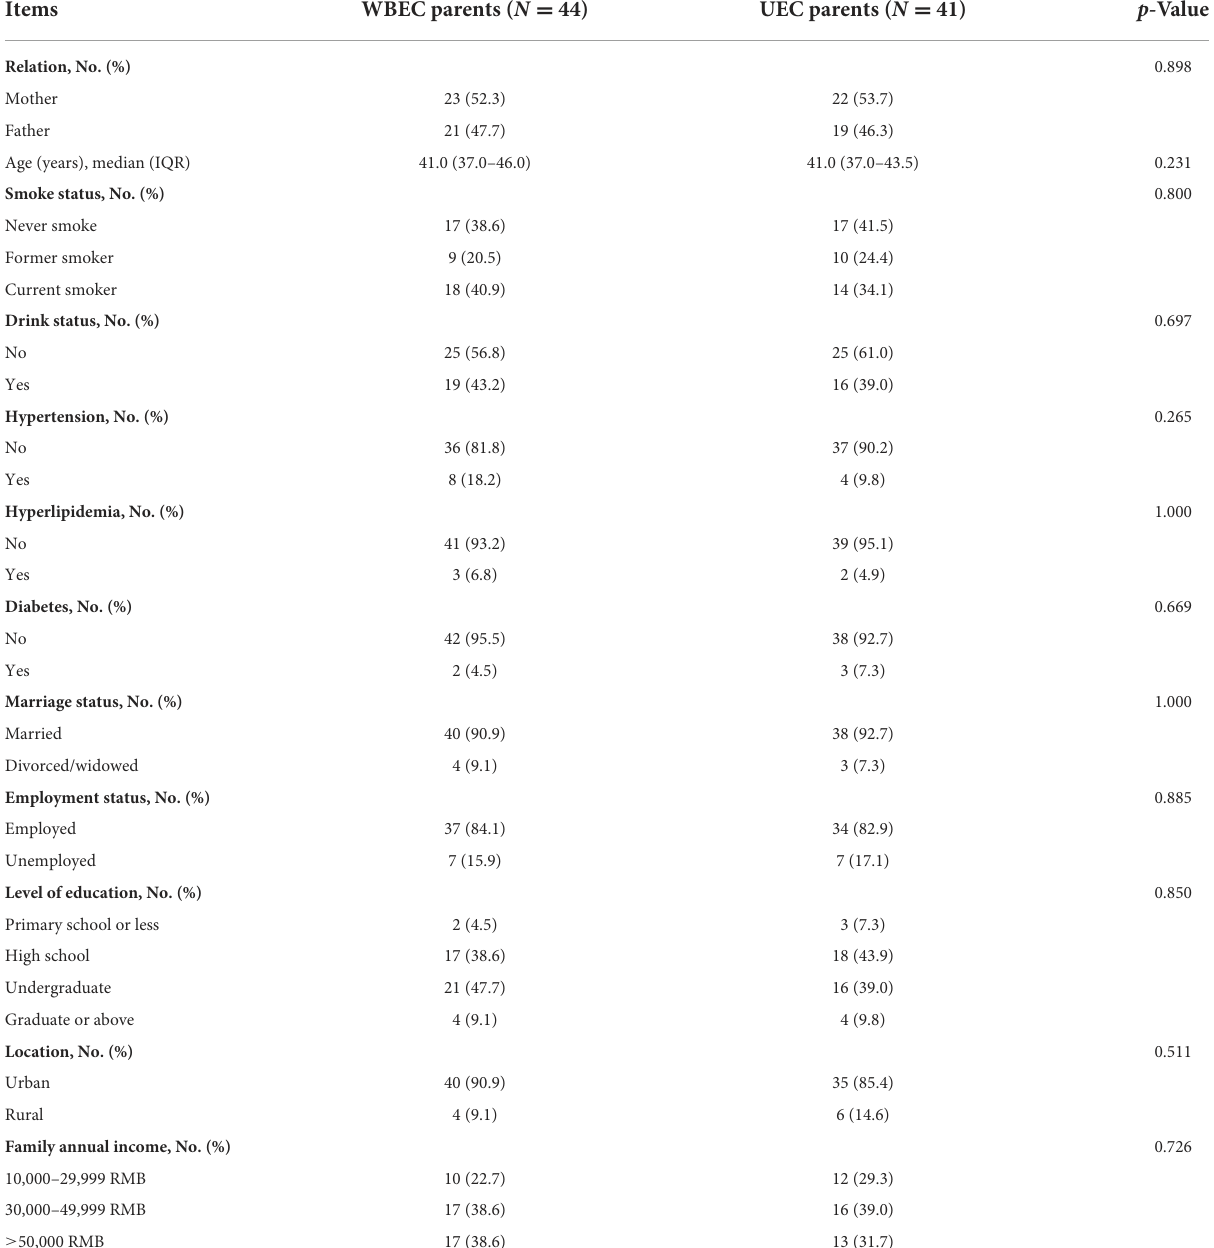
TABLE 2 Clinical characteristics of